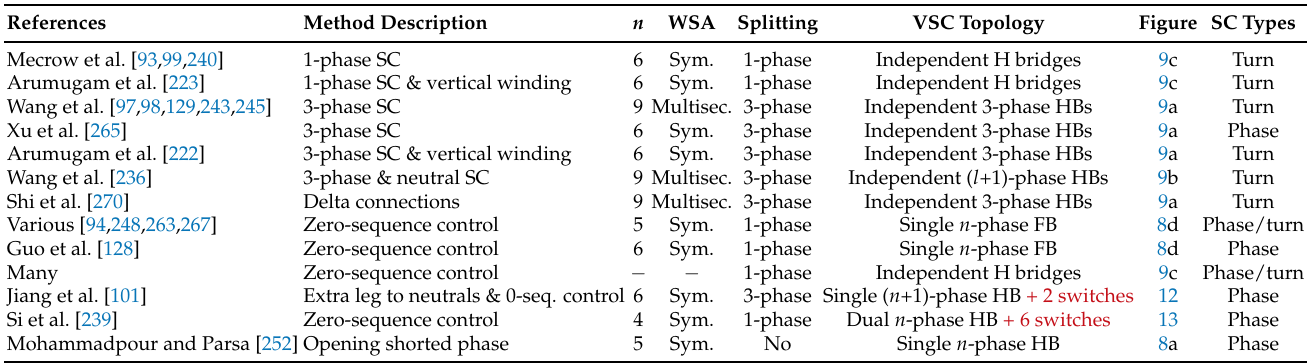
Table 9. Methods based on drive topology for tolerating stator SC faults (Section 5.3.1) in multiphase applications in the